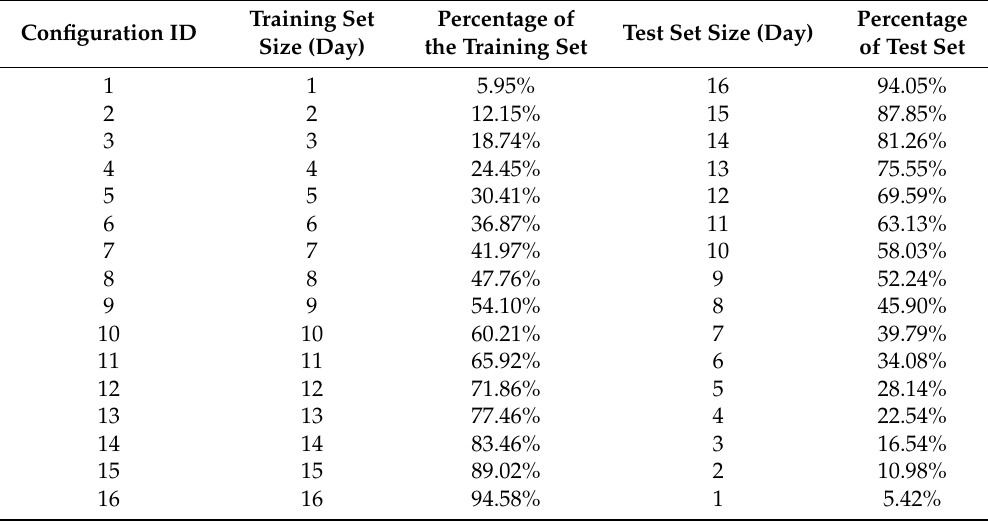
Table A4. The configurations of the training sets and test sets in the Indianapolis